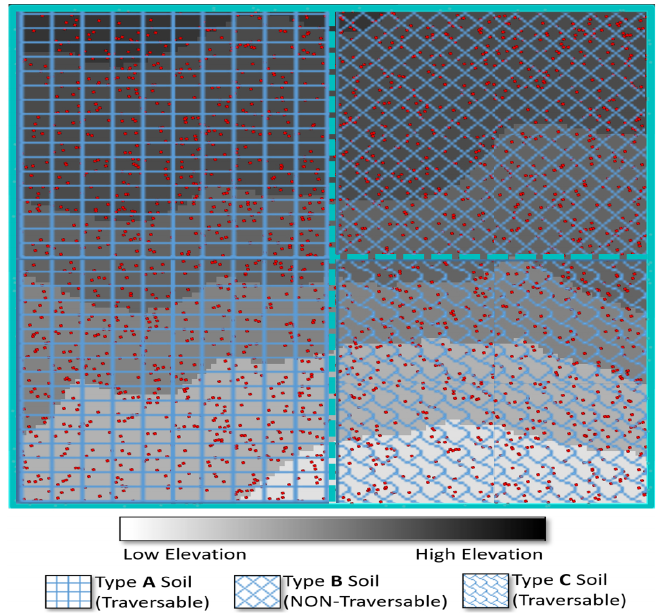
Figure 4. The area under study represented as a DEM map with information about soil type. The red dots represent the nodes visited by the UGV along its movement to the destination.